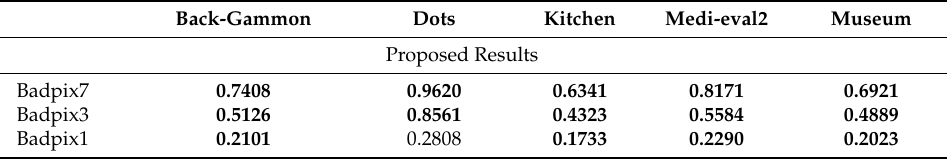
Figure 25. Visual comparison of the proposed algorithm with Strecke et al. [9], Wang et al. [10], Zhang et al. [11] and Shin et al. [12] for synthetic LF images with added noise. Table 5. Quantitative depth map comparison for synthetic data to ground truth for different algo- rithms for noisy